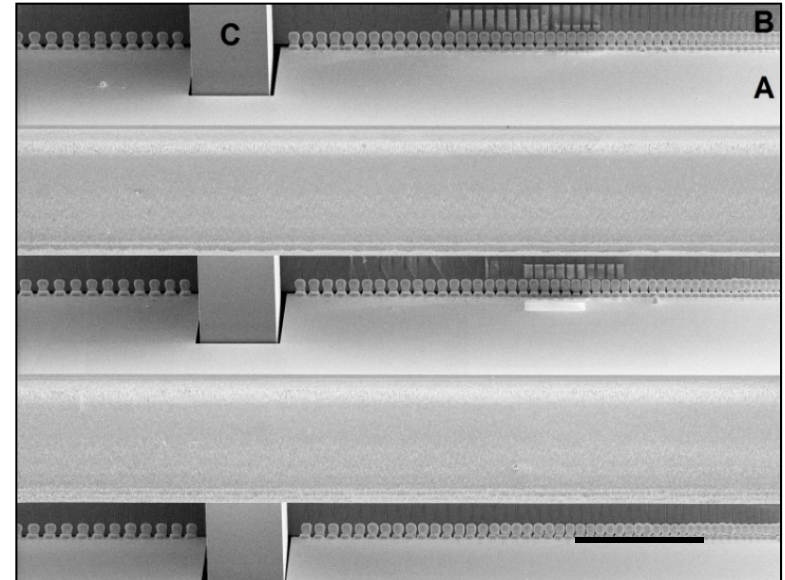
Figure 12. Example of a plating pitch test, showing several 2-D inserts (A) after electrical connections were formed to the holder plate (B). The self-locking hook (C) is visible. Each insert has a very fine pitch on the right and then relaxes the pitch towards the left. The finest pitch pads are visibly merged and overplated. Pads towards the left are clearly separated. The transition in this example occurred at around 35–40 µm but depends on the amount of plating necessary to bridge the gap (see Table 3). Scale bar is 500 µm.